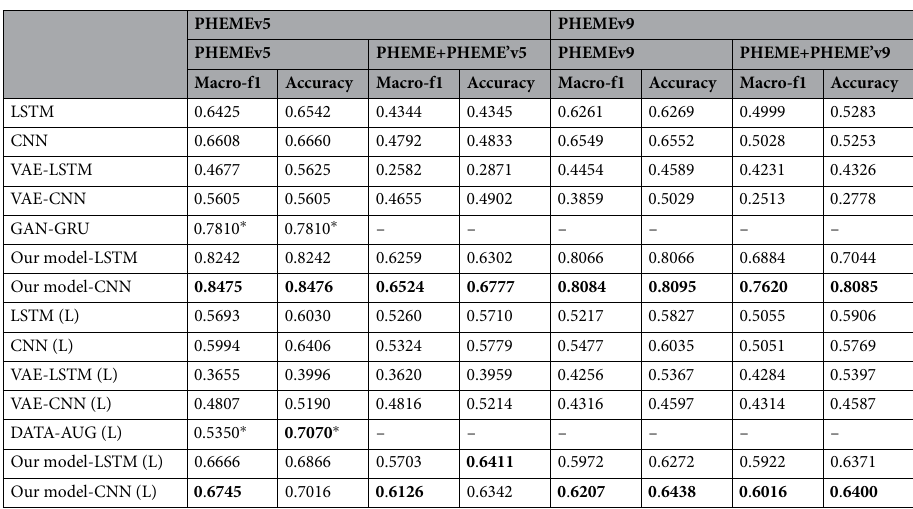
Table 1. Macro-f1 and accuracy comparison between our model and baselines on the rumor detection task. The models are trained on PHEME and tested on both original dataset PHEME and augmented dataset PHEME+PHEME’. *indicates the best result from the work that proposed the corresponding model. L represents the model is evaluated under leave-one-out principle. Variance results in cross-validations are shown in Table 2. The best results are marked in bold.